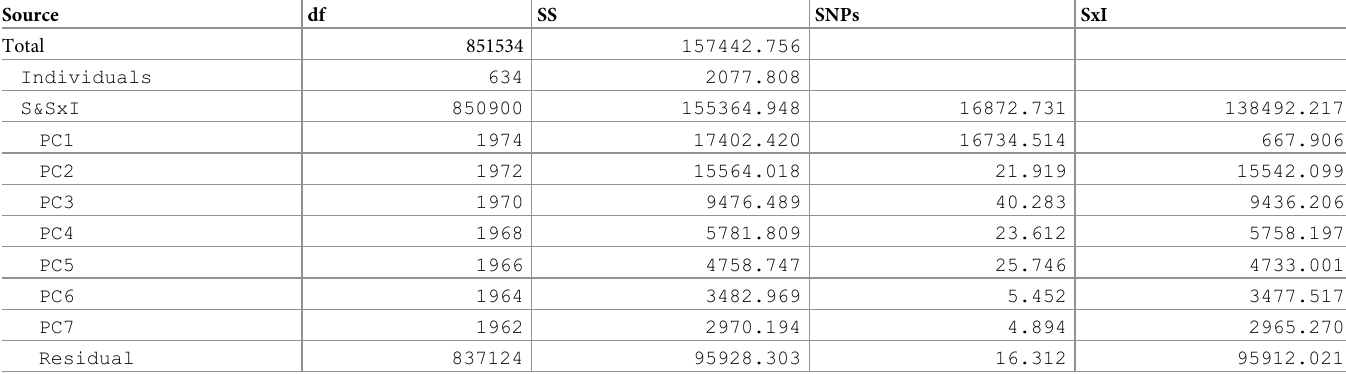
Table 3. Augmented ANOVA table for Individual-Centered PCA of SNP data on oats, using SNP coding rare = 1. PCA is applied to SNP main effects and S × I interac- tion effects combined (S&S × I), and the portion of each is shown in the last two columns. Source